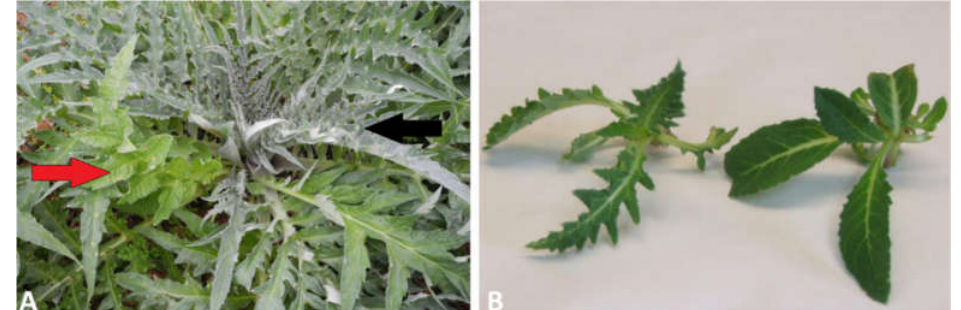
Figure 1. ‘Spinoso sardo’ plants showing aberrant phenotype. ( A ) Example of an aberrant ‘Spinoso sardo’ plant in field, showing branches with both standard true-to-type (red arrow) and off-type (black arrow) leaves. ( B ) In vitro plantlets showing off-type (on the left) and true-to-type (on the right) leaves.